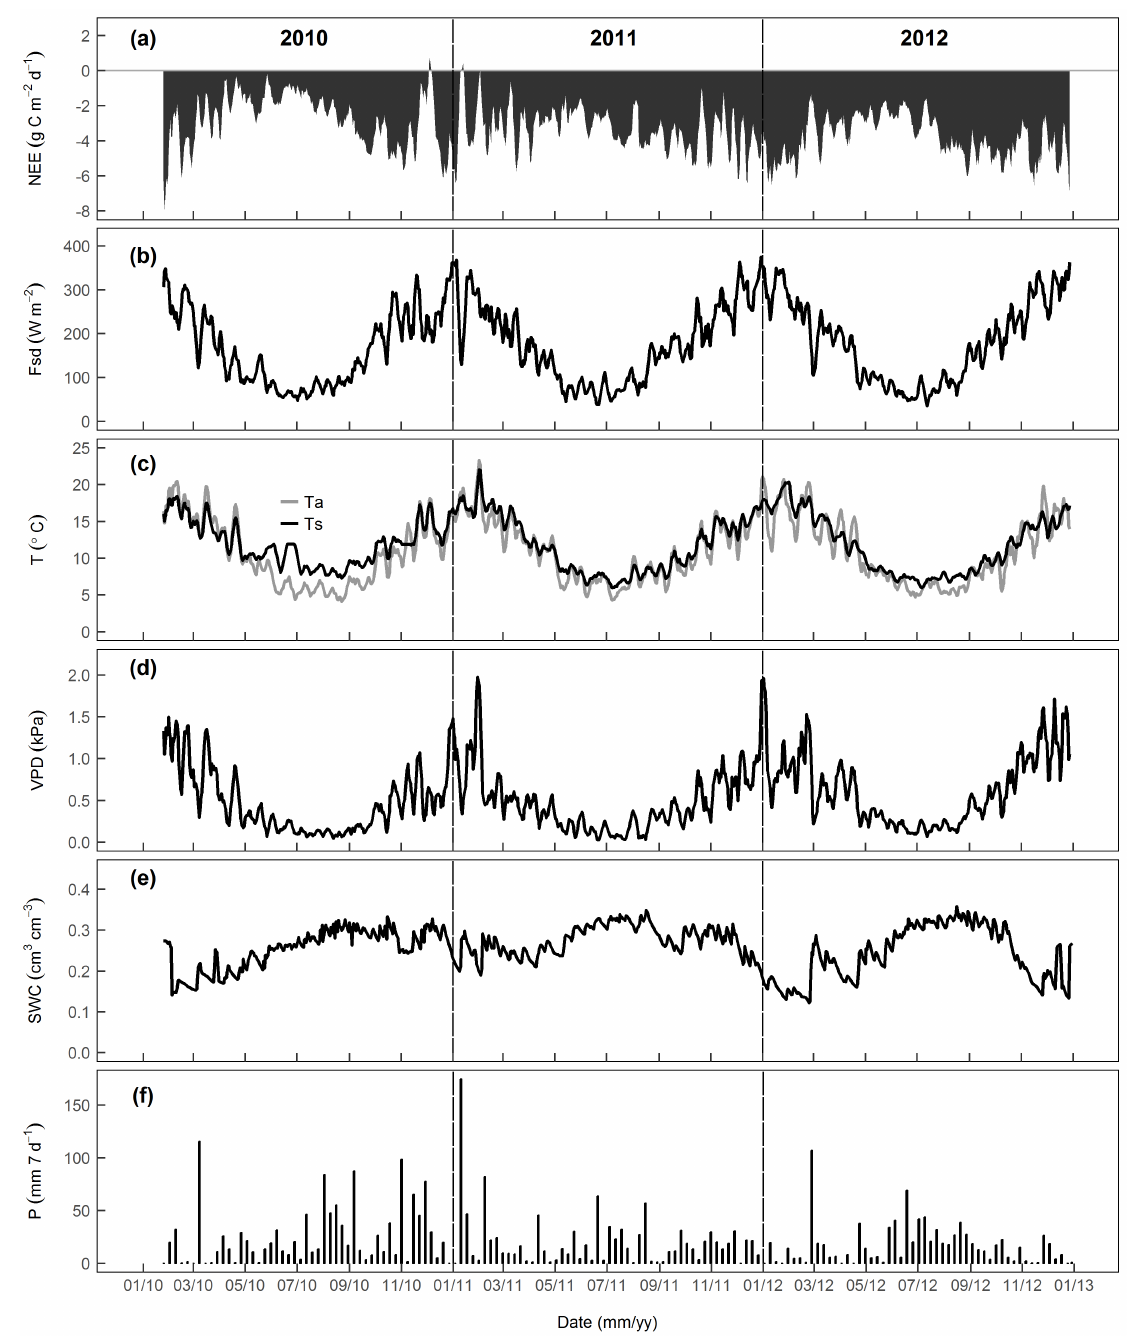
Figure 2. Time series of (a) 7-day running means of daily total net ecosystem exchange (NEE), 7-day running means of daily averages of (b) incoming solar radiation ( F sd ), (c) air ( T a ) and soil ( T s ) temperature, and (d) 7-day running means of mean midday (11:00–13:00AEST) vapour pressure deficit (VPD), (e) daily averages of volumetric soil water content (SWC), and (f) 7-day sums of rainfall ( P ) from 2010 to